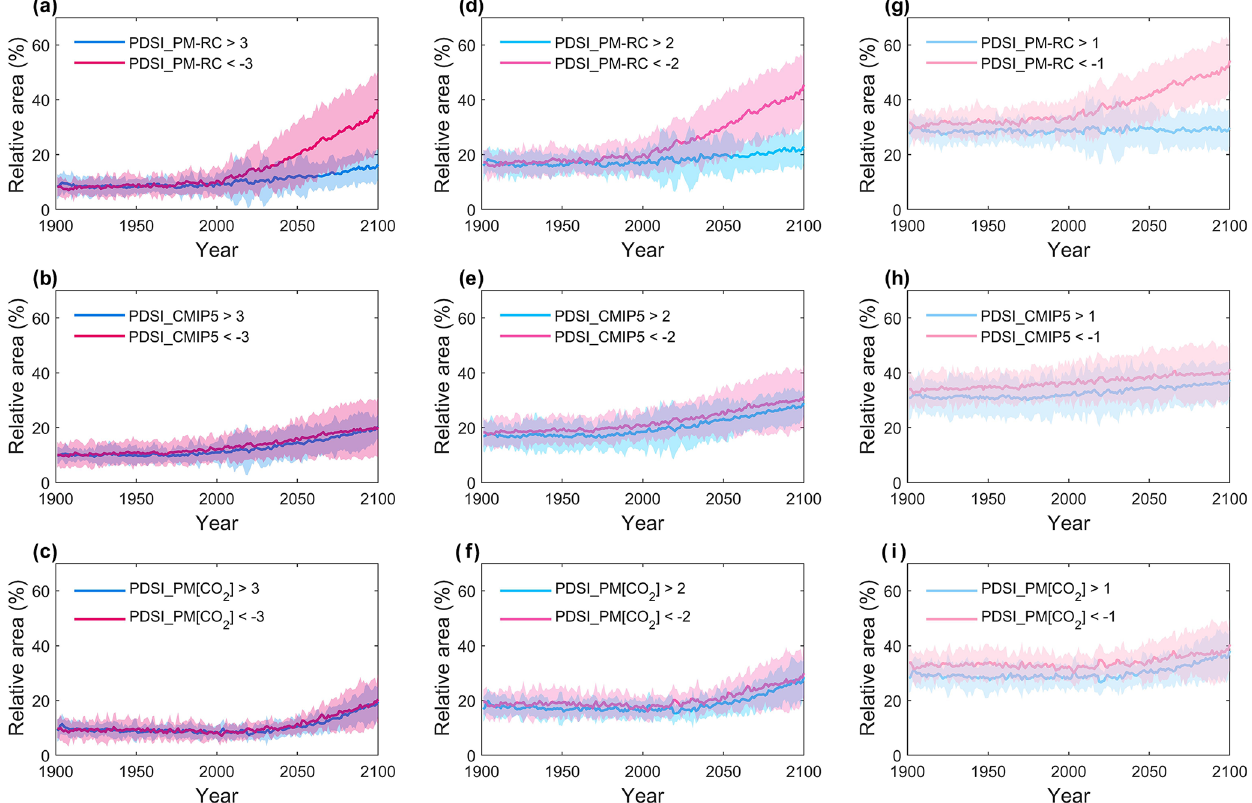
Figure 5. Time series of the global average fractional land area experiencing drought/moist conditions. (a–c) Global average time series of land area experiencing severe drought (PDSI < − 3 . 0, red) and exceptionally moist (PDSI > 3 . 0, blue) conditions for (a) PDSI_PM- RC, (b) PDSI_CMIP5, and (c) PDSI_PM[CO 2 ], respectively. (d–f) Global average time series of land area experiencing moderate drought (PDSI < − 2 . 0, red) and moist (PDSI > 2 . 0, blue) conditions for (d) PDSI_PM-RC, (e) PDSI_CMIP5, and (f) PDSI_PM[CO 2 ], respectively. (g–i) Global average time series of land area experiencing mild drought (PDSI < − 1 . 0, red) and moist (PDSI > 1 . 0, blue) conditions for (g) PDSI_PM-RC, (h) PDSI_CMIP5, and (i) PDSI_PM[CO 2 ], respectively. The solid curves represent the ensemble mean of 16 CMIP5 models and the shading represents the range by individual models. The time series are averaged over global land areas excluding Greenland and